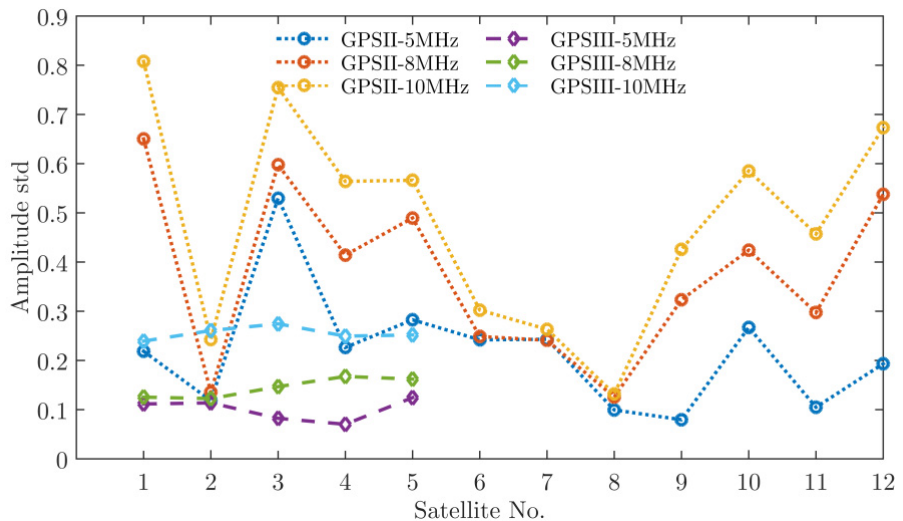
Figure 12. Standard deviations of amplitude under different bandwidths.